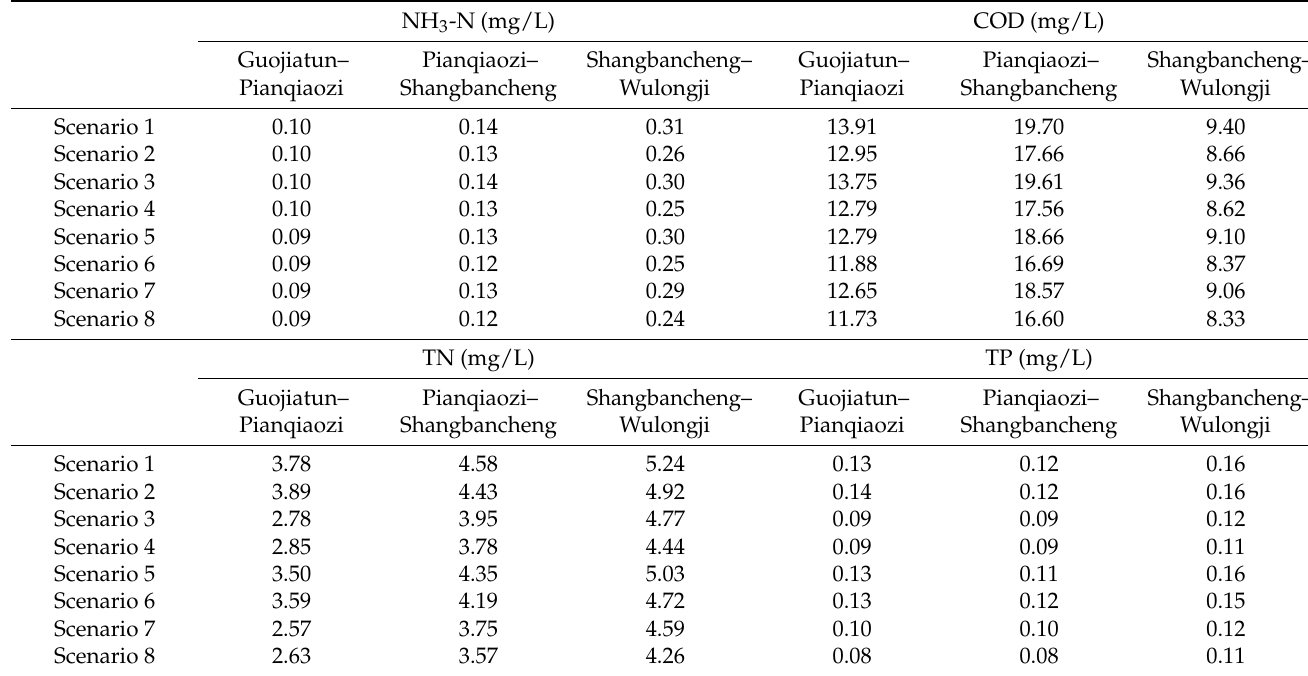
Table A2. Water quality simulation results under different water pollution control schemes.